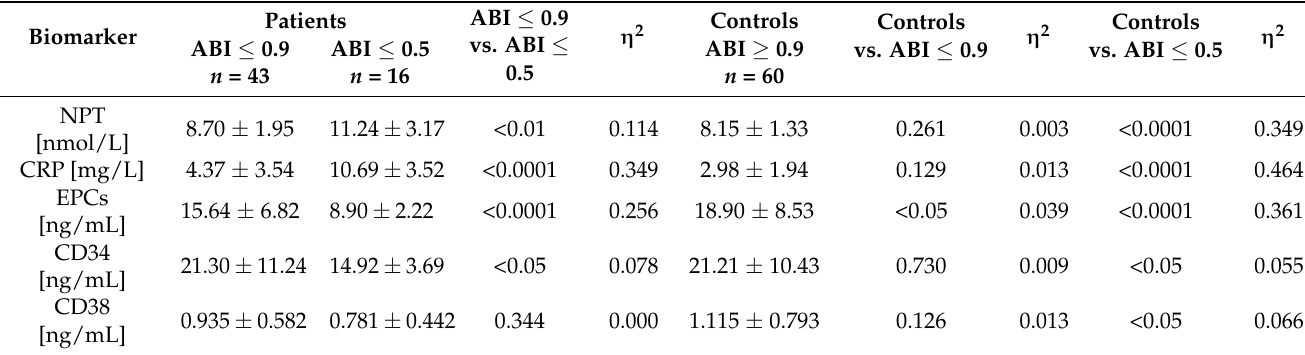
Table 5. Inflammatory markers and progenitor cells (mean ±